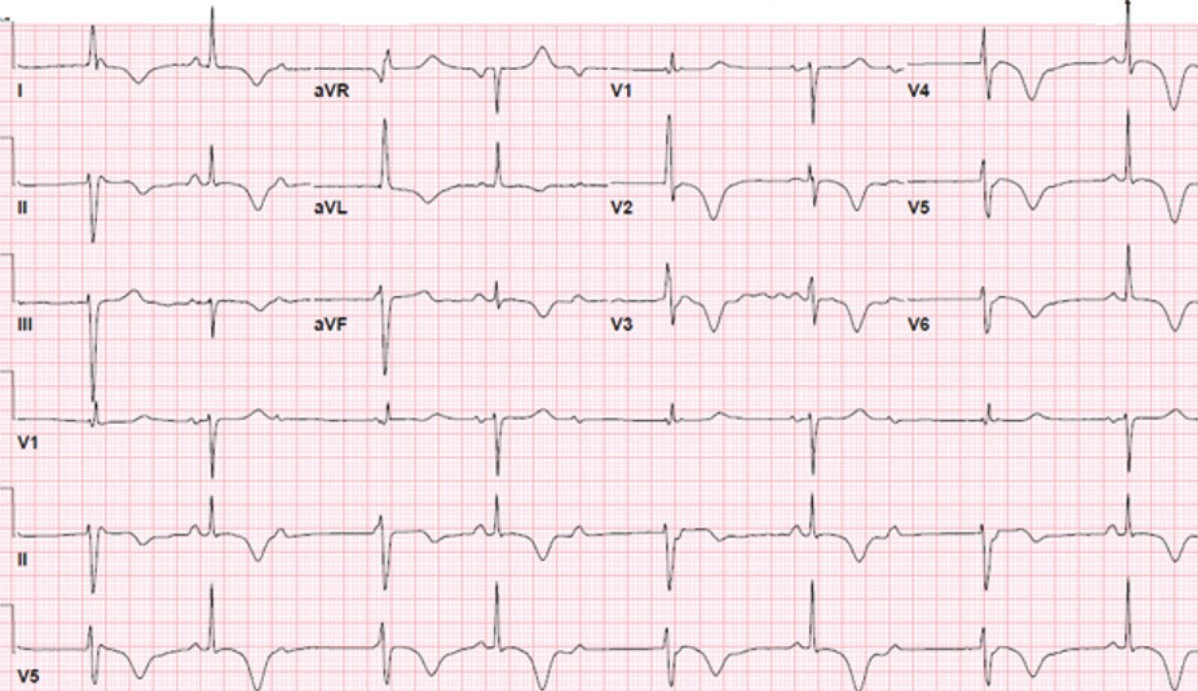
Figure 2: Electrocardiogram showing second-degree Mobitz type 2 AV block, 2: 1 conduction, and marked T wave inversion on anterolateral leads suggesting ischemia.